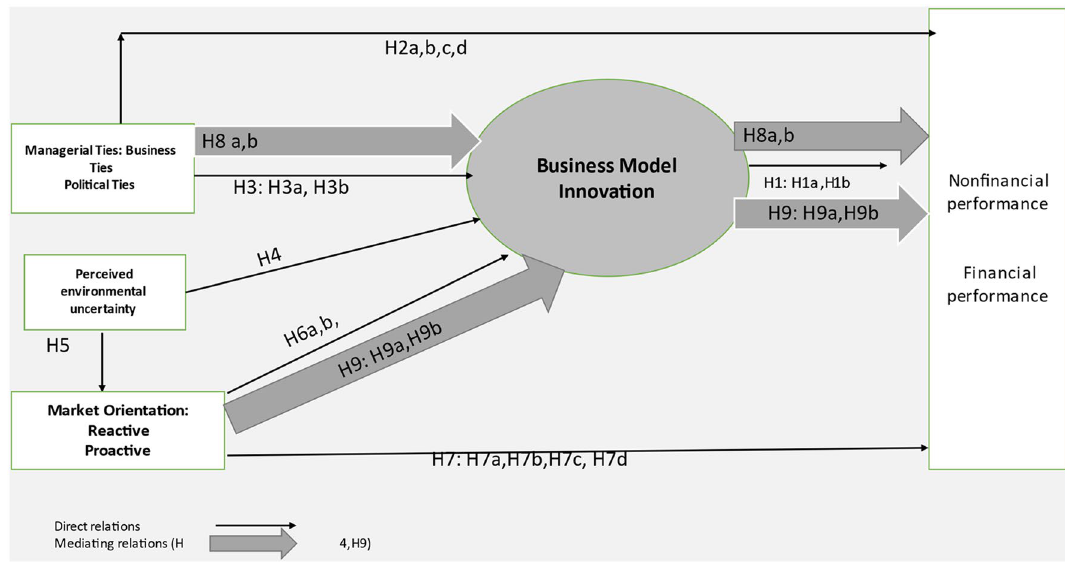
Fig. 1 Research model. Source : the